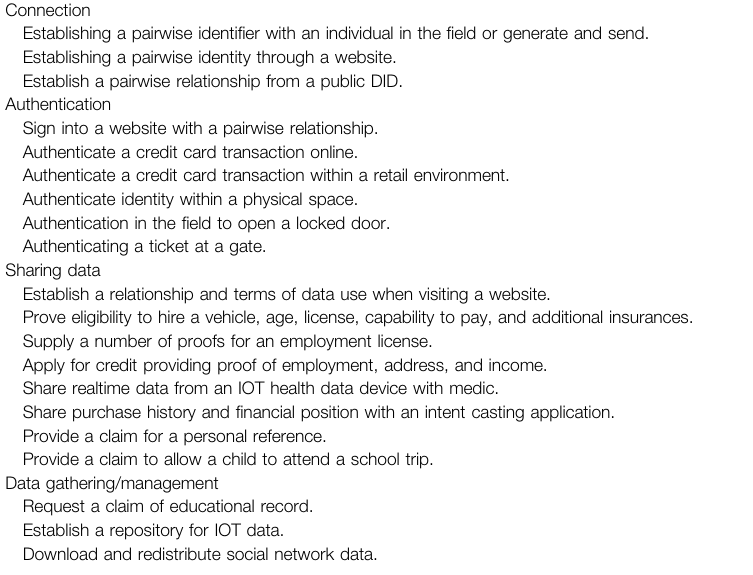
TABLE 1 | Simpli fi ed table presenting SSI case studies and user scenarios. Connection Establishing a pairwise identi fi er with an individual in the fi eld or generate and send. Establishing a pairwise identity through a website. Establish a pairwise relationship from a public DID. Authentication Sign into a website with a pairwise